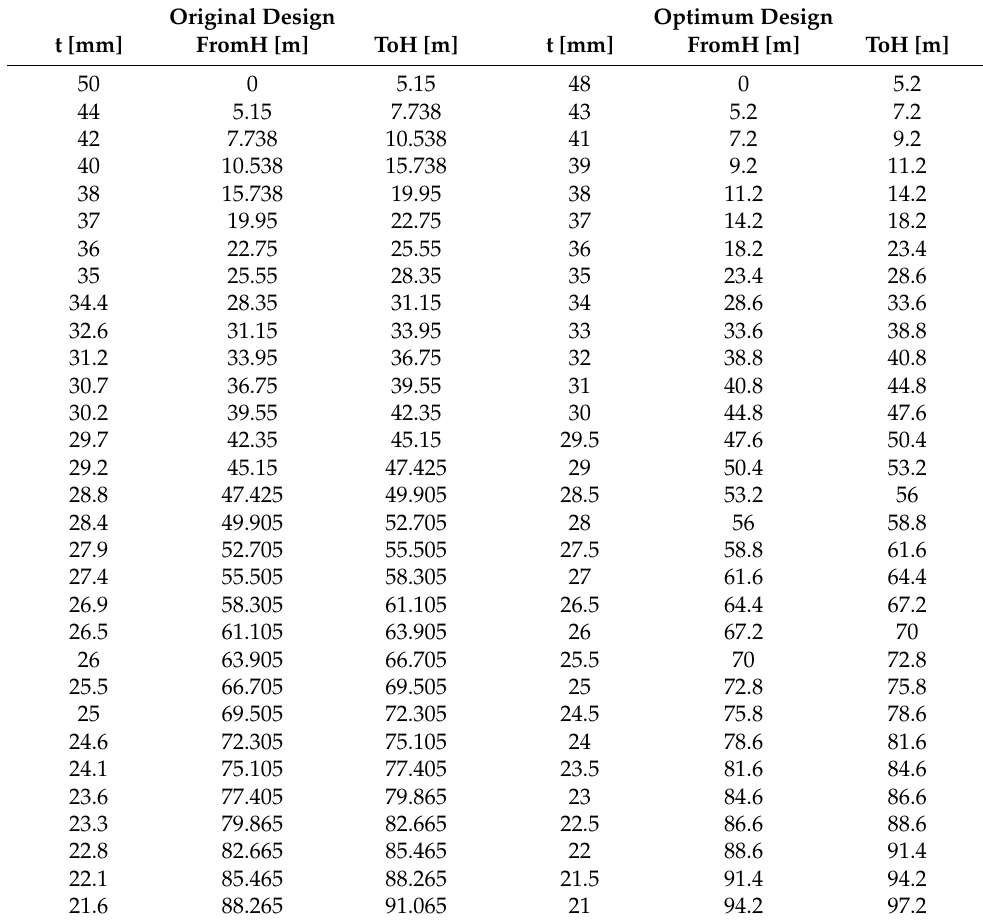
Table 3. Original and optimum tower segment thickness of 3 MW